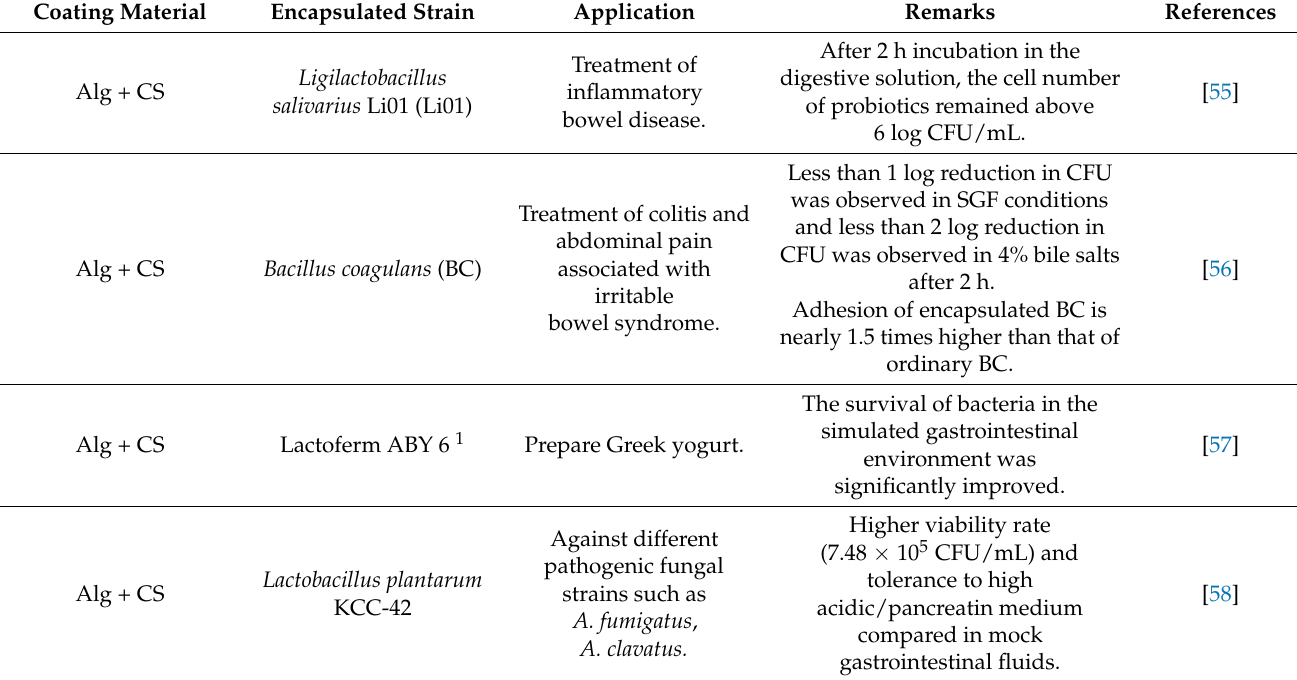
Table 2. Microencapsulation of probiotics with chemically modified alginate. Coating